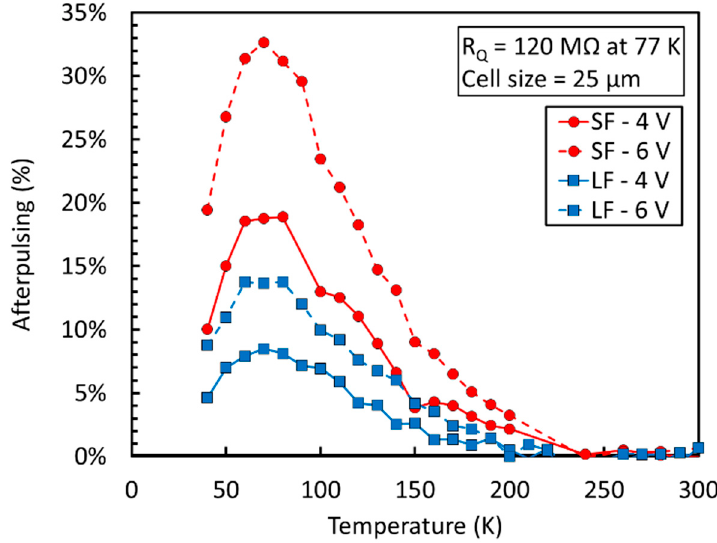
Figure 18. Afterpulsing probability (AP) as a function of the temperature for the NUV-HD and NUV-HD-LF technologies. Measures taken from Reference